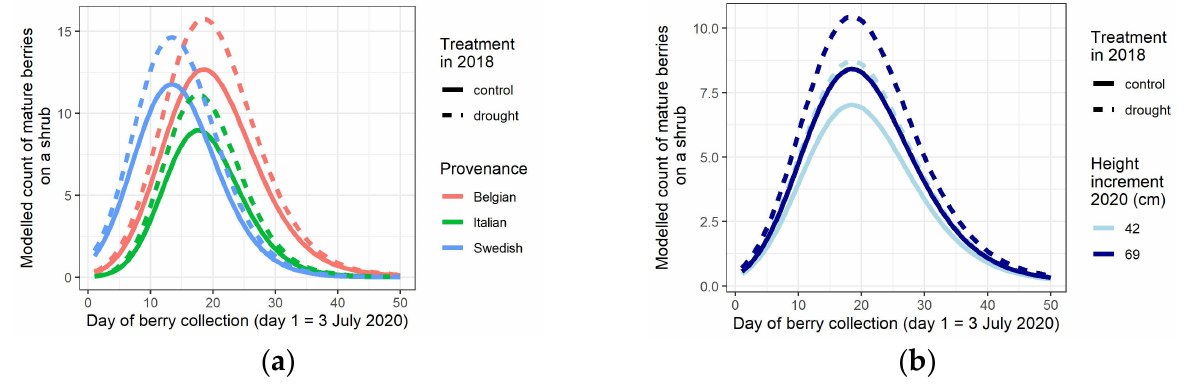
Figure 3. Modelled mature berry production on a shrub over time in 2020 for drought-treated and control plants, according to the provenance ( a ) and to the height of the plants ( b ). Table 4. Statistical analysis of the mean weight of a stone in 2020. In the model, the Belgian provenance is the standard to which the Italian (It) and Swedish (Sw) provenances are compared, and for the treatment in 2018 (T), the control is the standard to which the water limitation is compared.